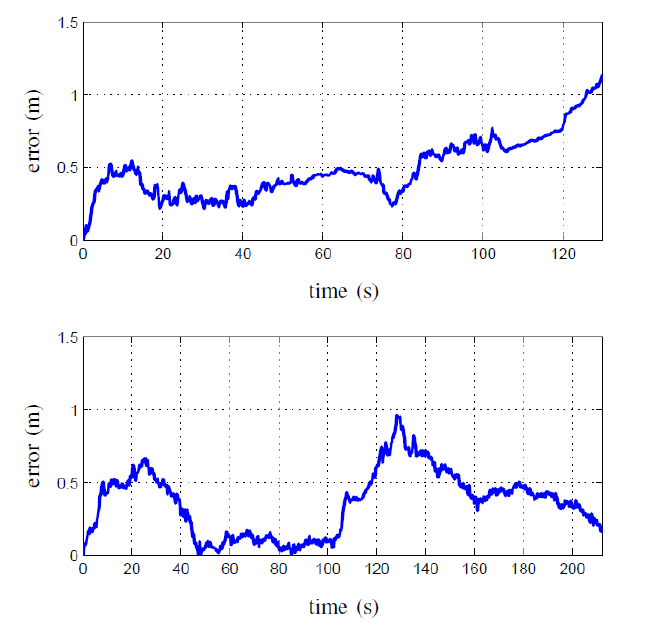
Figure 10. The Euclidean error over time, as measured against DGPS , of a FastSLAM system using SURF features on the first dataset ( top ) and SIFT features on the second dataset ( bottom )